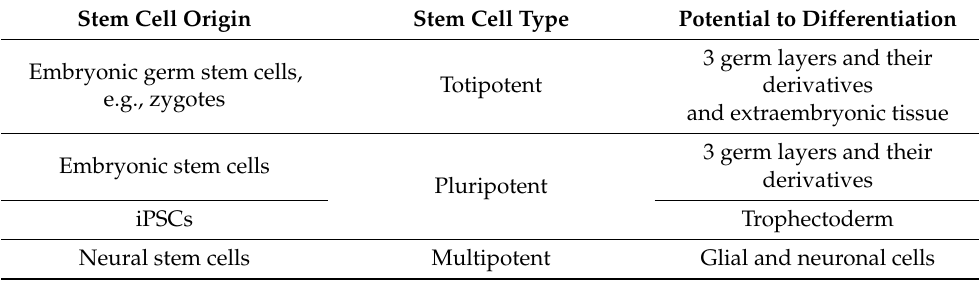
Table 1. Summary of characteristics considered in stem cell